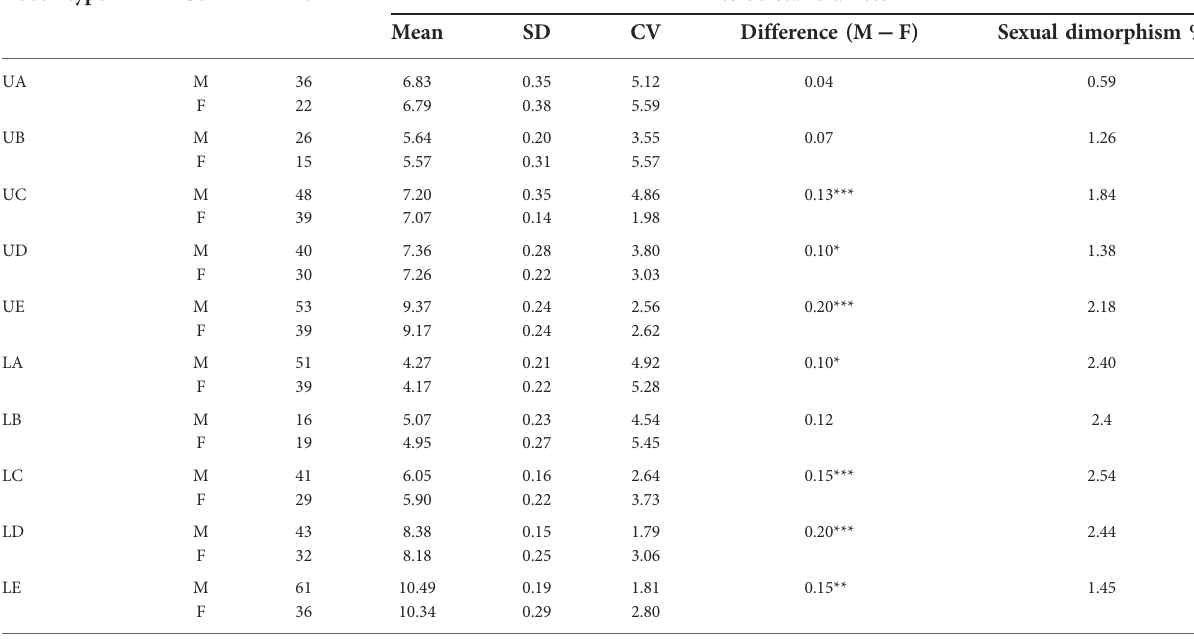
TABLE 4 Mesiodistal diameter (mm) and sexual dimorphism of the total sample. Tooth